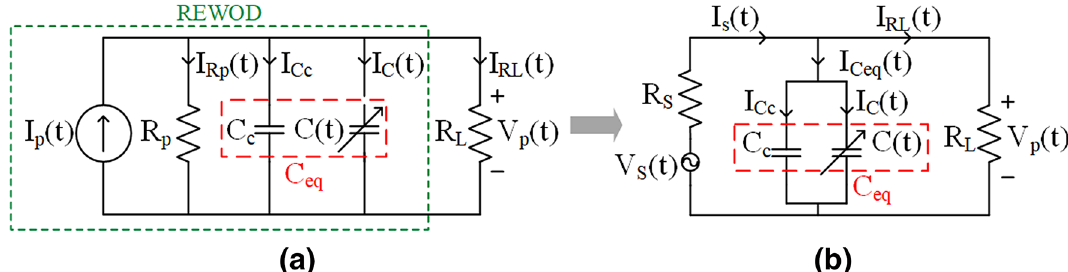
Figure 2. ( a ) Current-based, ( b ) voltage-based lumped circuit model for porous REWOD